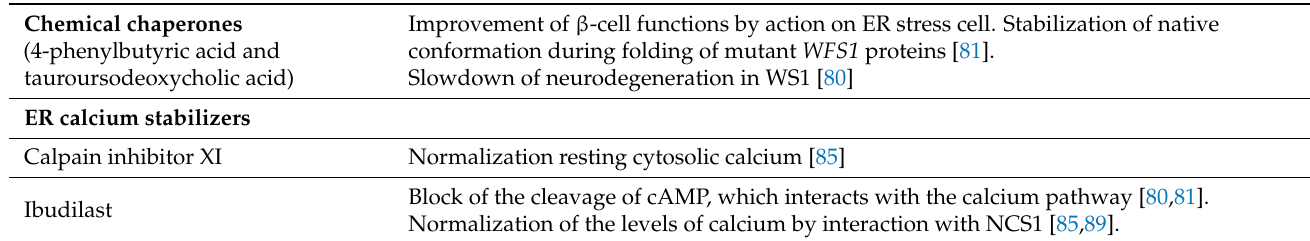
Table 3. Therapeutic strategies proposed for Wolfram syndrome